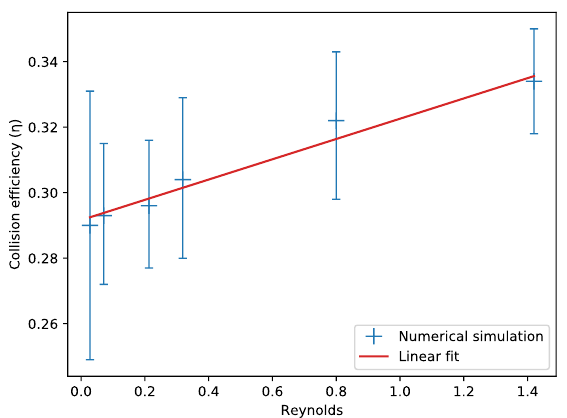
Figure 4. Collision efficiency for monodisperse particles as a function of Reynolds number: results from LBM simulations and linear fit from Equation (8).